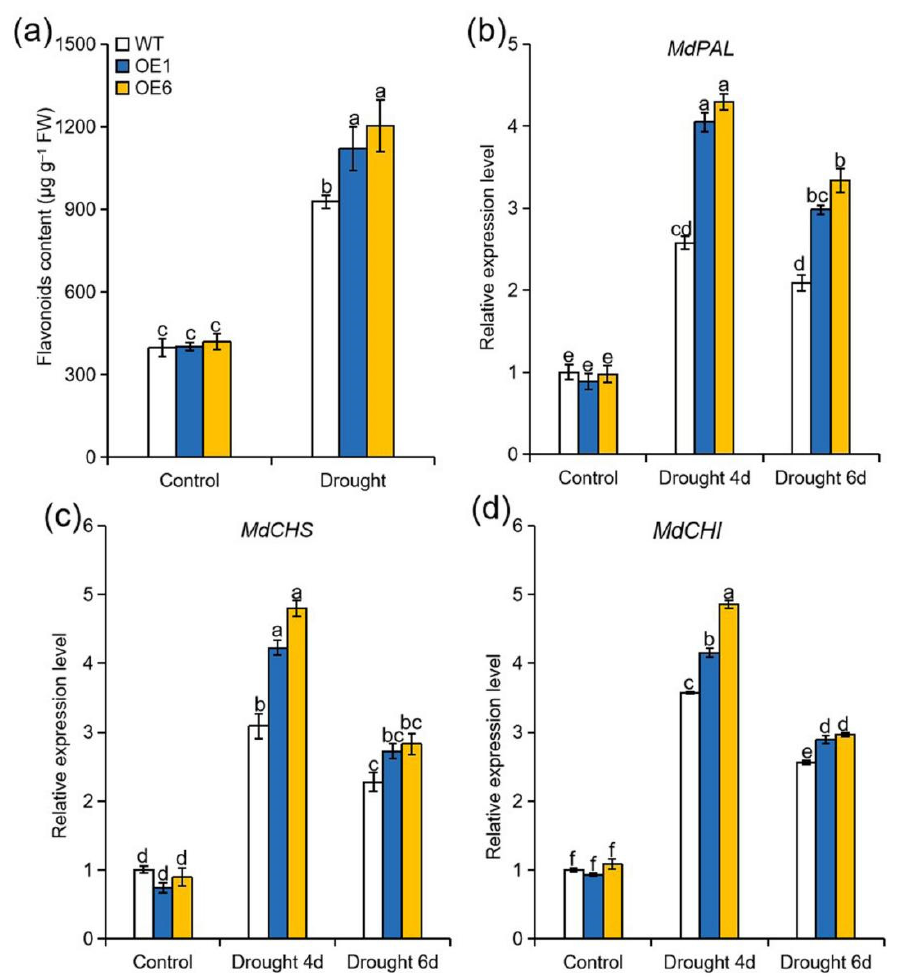
Figure 6. Effect of MdATG8i overexpression in apple on the accumulation of flavonoids under drought stress. ( a ) Flavonoid content in leaves of WT and MdATG8i OE plants. Expression levels of ( b ) MdPAL , ( c ) MdCHS , and ( d ) MdCHI in the leaves of WT and MdATG8i OE plants. The data are presented as means ± SD of three replicates. Values with different letters are significantly different ( p < 0.05, Tukey’s multiple range test).